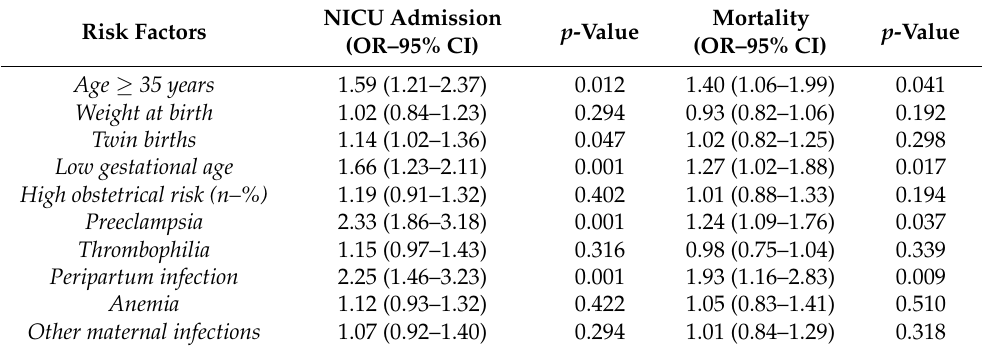
Table 3. Maternal risk factor analysis for in-hospital neonatal intensive care unit admission and mortality in premature newborns.